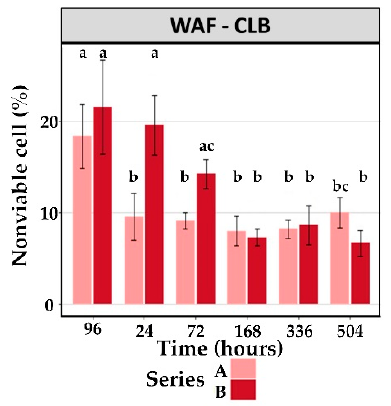
Figure 7. Fractions of nonviable lobster’ hemocyte cells for WAF-CLB treatment during the recovery period in series A and B. Mean ± SE; n = 3. The letter symbols indicate a significant (p < 0.05) effect between time and series.